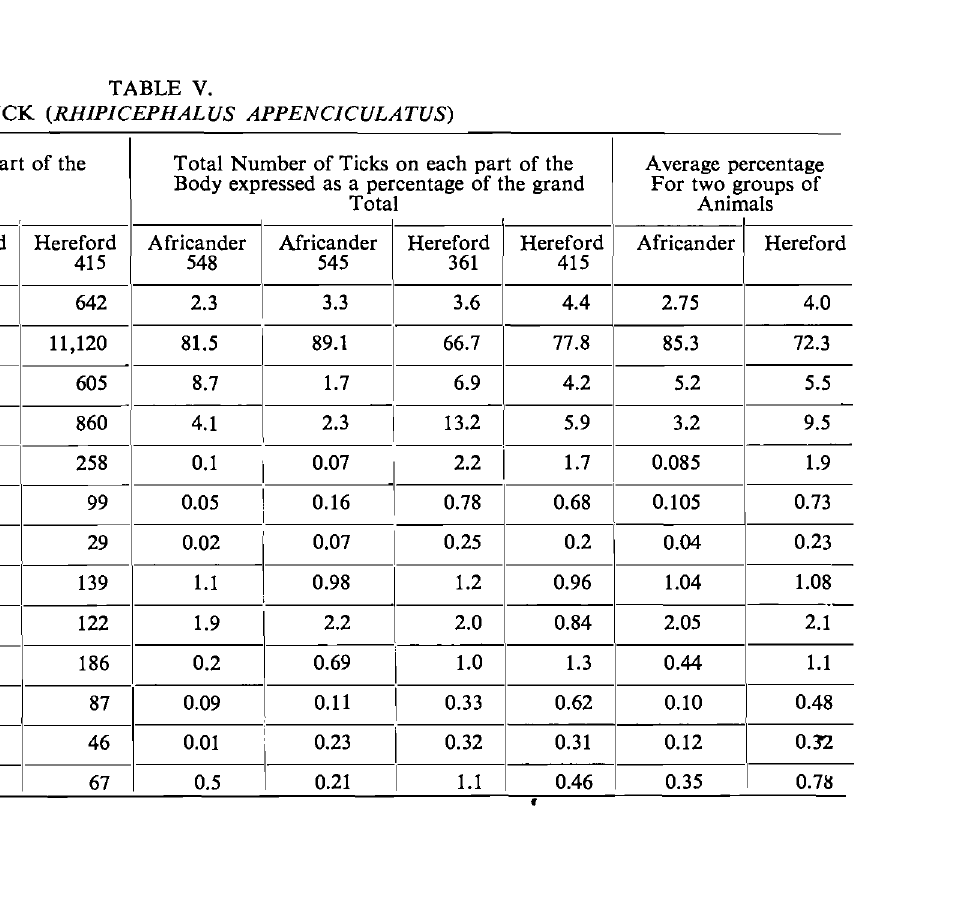
TABLE V. BROWN TICK (RHIPICEPHALUS APPENCICULATUS)